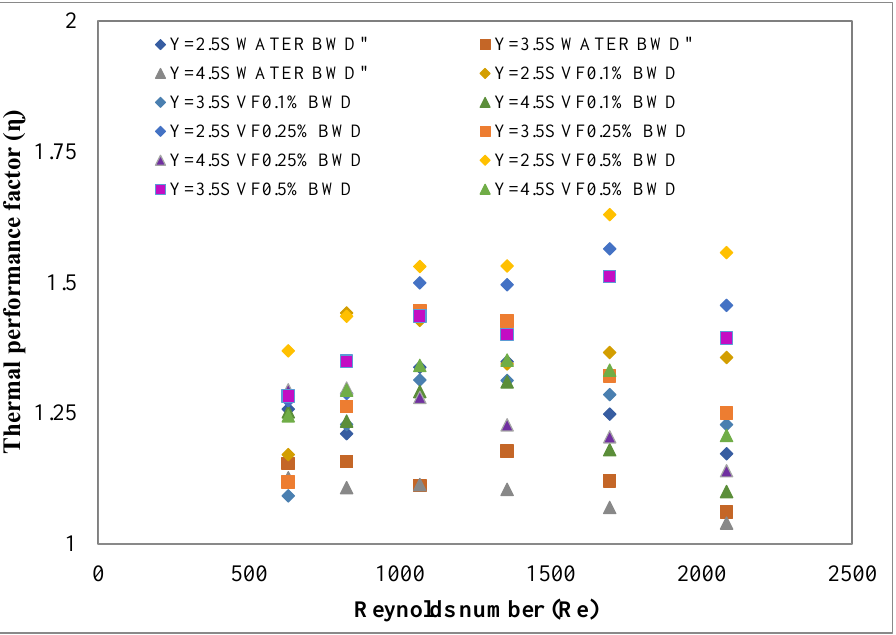
Figure 14. Thermal performance factor versus the Reynolds number for a staggered conical strip insert with the forward arrangement using deionized water and ZrO 2 / deionized water nanofluids under laminar flow conditioned.